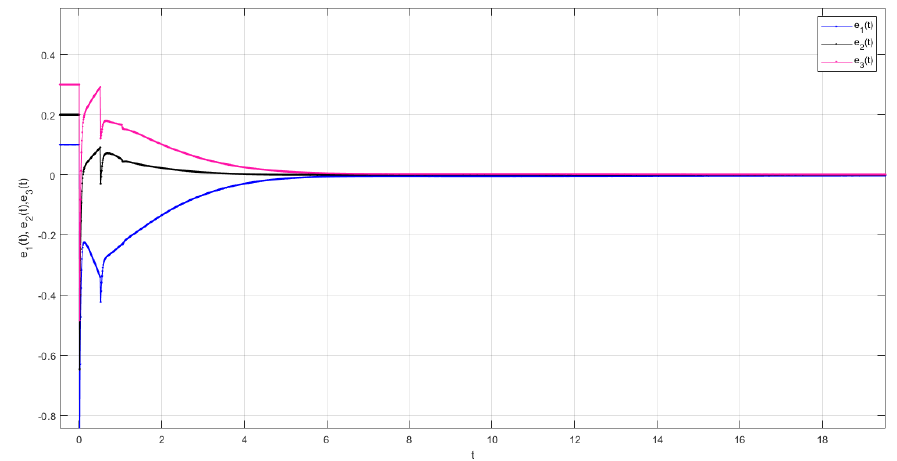
Figure 6. Structurally unbalanced bipartite leader